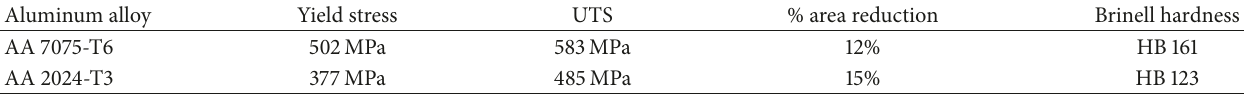
Table 1: Mechanical properties of the as-received, commercial aluminum alloys (AA) 7075-T6 and 2024-T3. Aluminum alloy